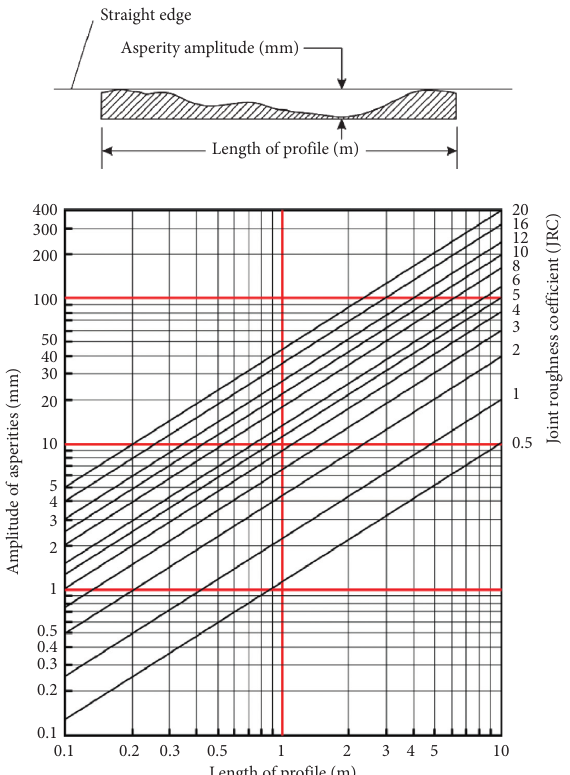
Figure 3: Alternative method for estimating JRC from measurements of surface roughness amplitude from a straight edge